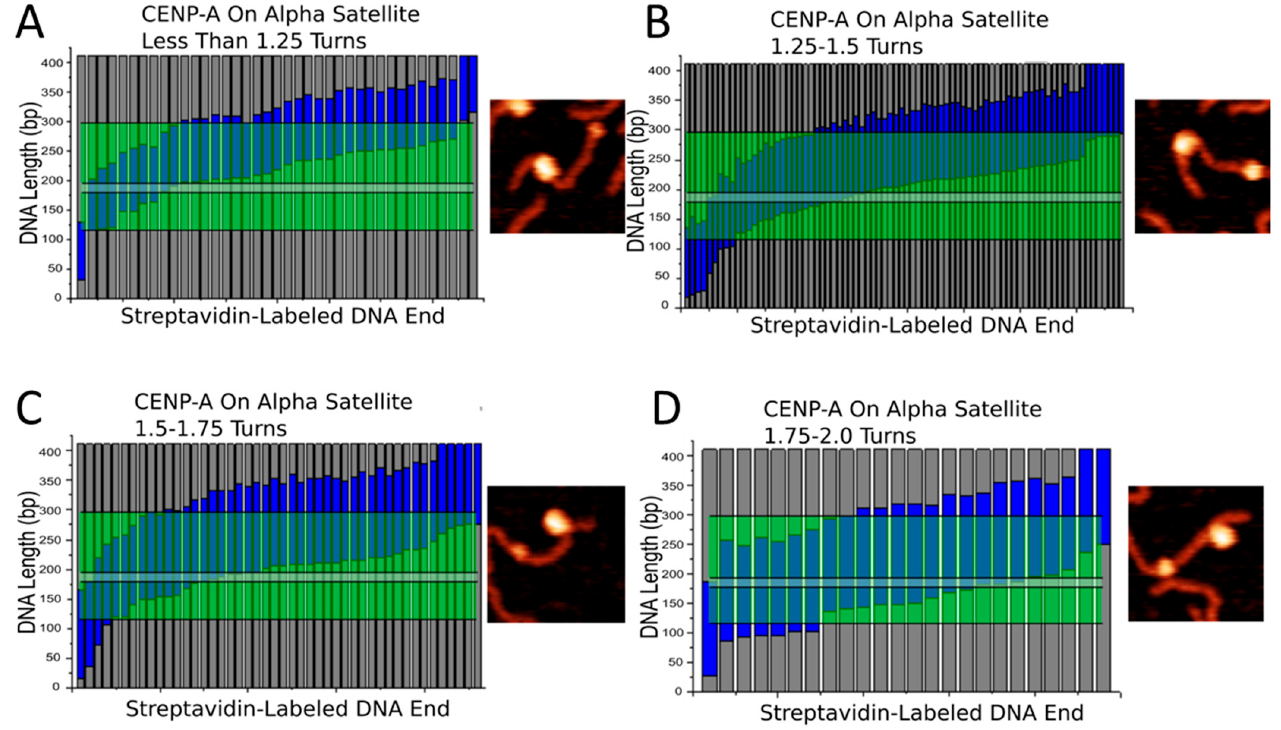
Figure 7. Mapping of CENP-A nucleosome position on the α -satellite substrate based on wrapping efficiency. Each bar denotes a single nucleosome. Dark gray regions indicate free DNA flanks. Blue regions indicate DNA wrapped around nucleosome core. Green regions indicate the position of the α -satellite motif. Thin gray line indicates position of the CENP-B box. Representative image of nucleosome with corresponding wrapping efficiency shown to the right of each map. ( A ) Under wrapped nucleosomes. ( B ) Fully wrapped nucleosomes. ( C , D ) Over wrapped nucleosomes.